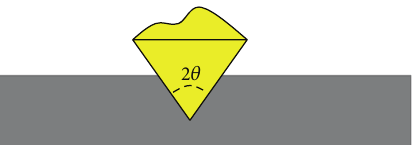
Figure 4: Modeling of the indentation depth of a single nanodia-